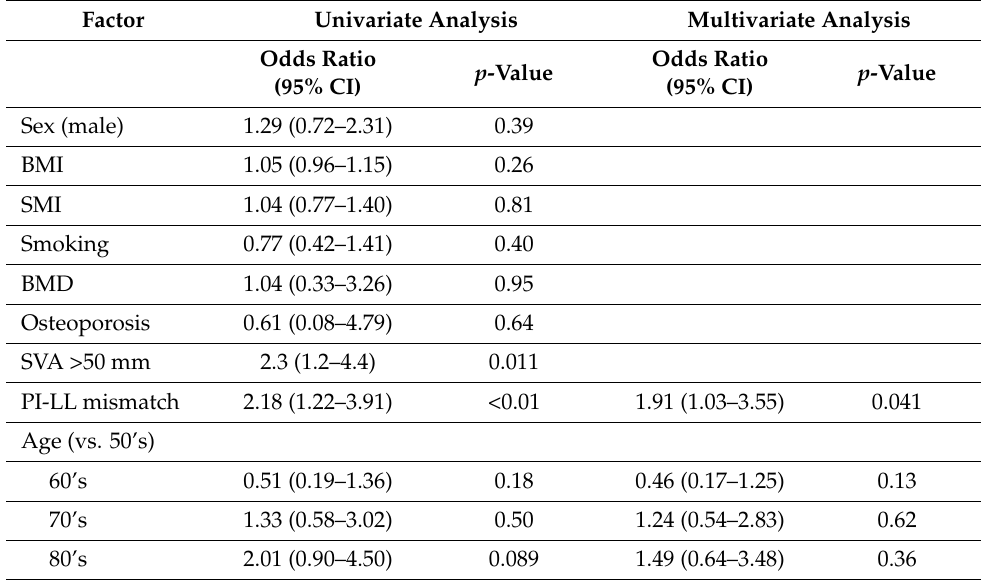
Table 3. Effects of subject-specific factors on low back